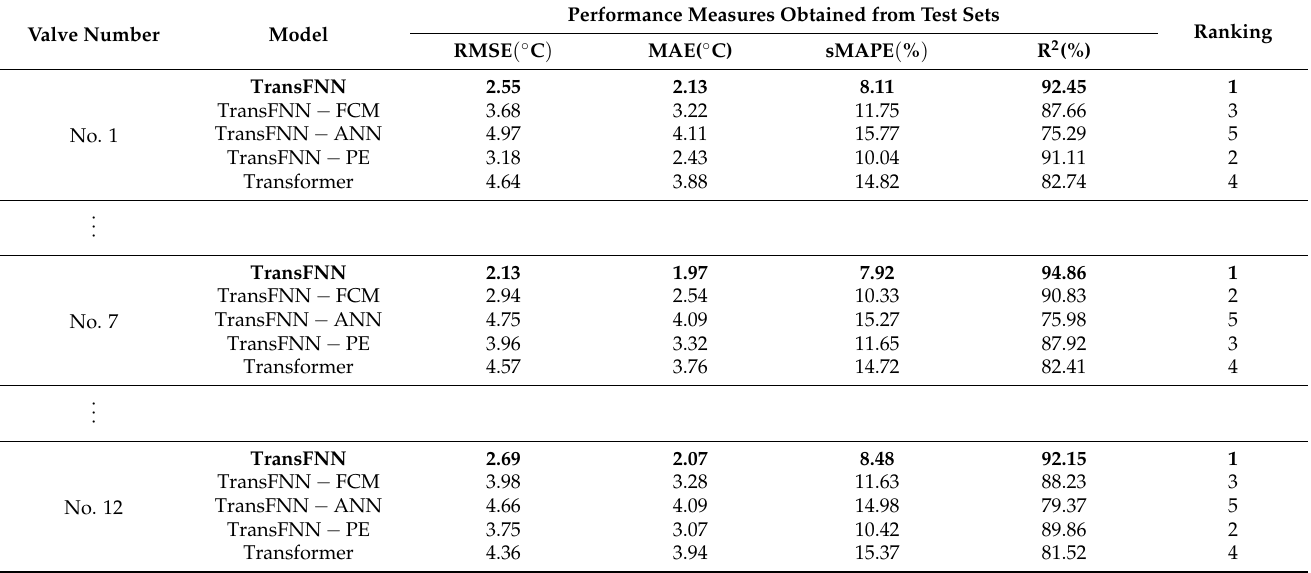
Table 2. Performance comparison of the five